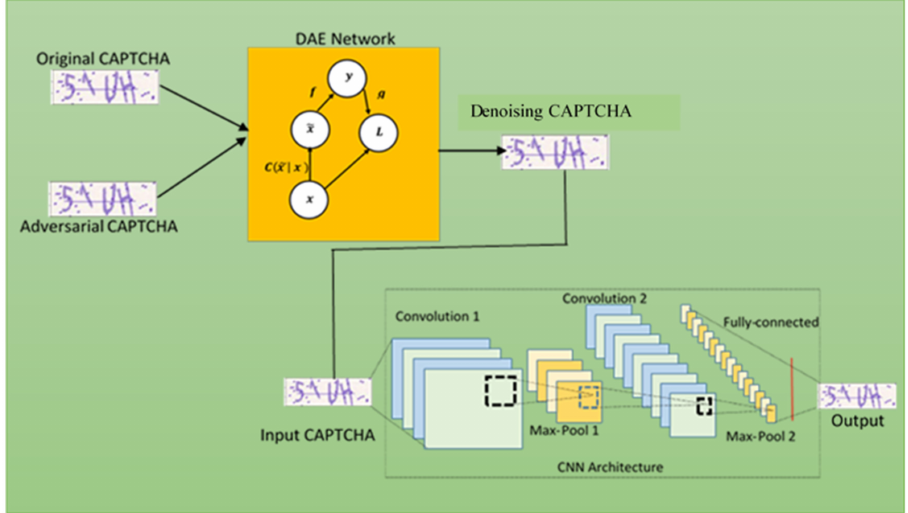
Figure 8. The workflow of the proposed baseline deep learning model for adversarial text-based CAPTCHA security